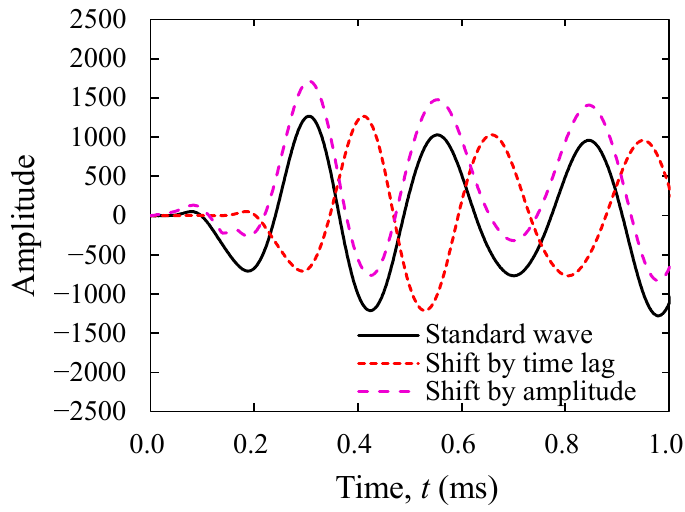
Figure 7. Measurement waveform.